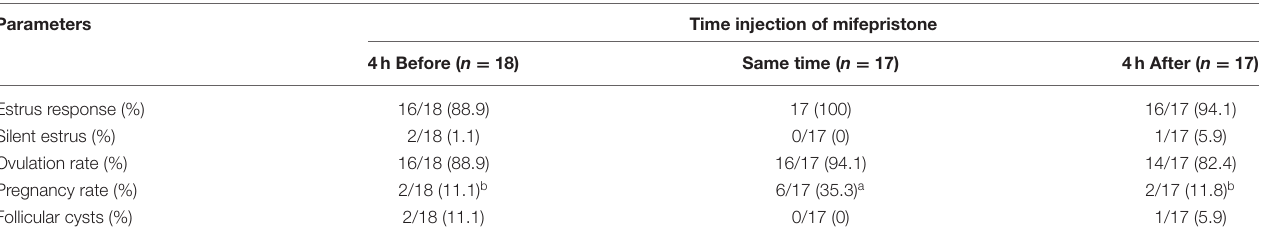
TABLE 3 | Effect of mifepristone injection time (4h before, same time, or 4h after second GnRH) on estrus, ovulation, and pregnancy of buffaloes synchronized by GPGMH during breeding season.